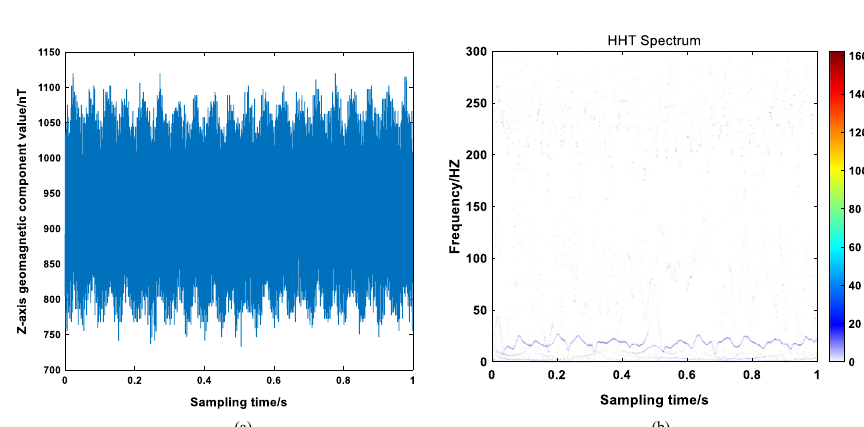
Fig. 14 H Z and HHT spectrum of original measurement signal of geomagnetic sensor